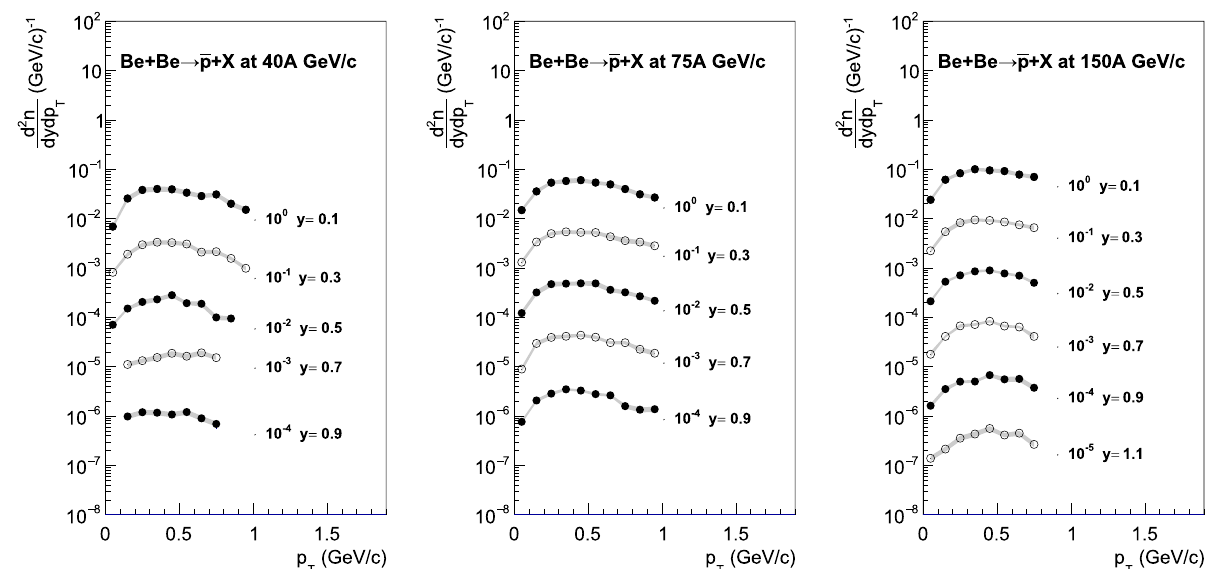
Fig. 25 Transverse momentum spectra inrapidity slicesof antiprotons produced in the 20% most central Be+Be collisions. Rapidity values giveninthelegendscorrespondtothemiddleofthecorrespondinginter-